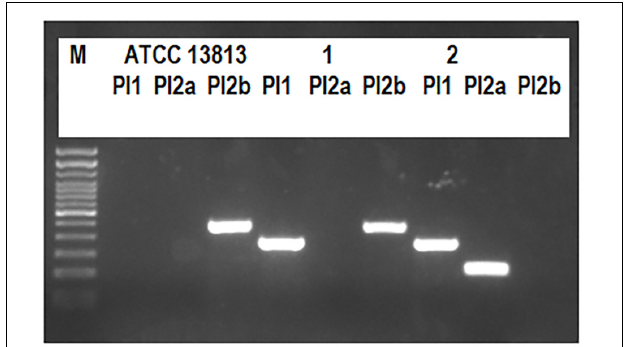
FIGURE 1 | Pilus island typing. The expected fragment sizes were 394, 243, and 519 bp for PI-1, PI-2a, or PI-2b, respectively. The image shows the pilus island profiles obtained for the ATCC 13813 strain, and for the human 1–109 (1) and 2–109 (2) isolates.